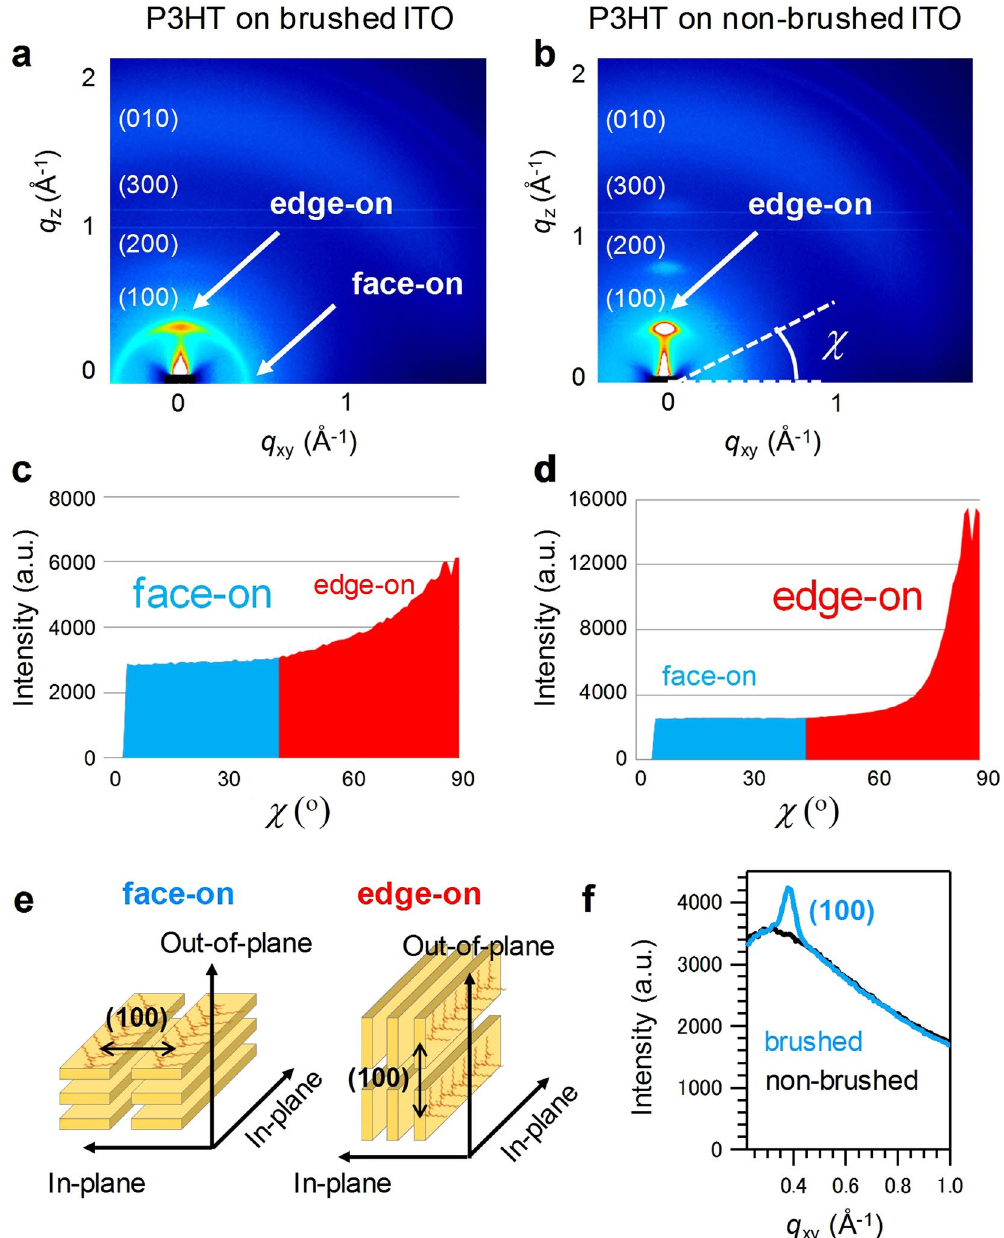
Figure 4. ( a , b ) GIXD patterns of P3HT thin films, and ( c , d ) intensities of (100) peaks as a function of the pole angle χ , for films on ( a , c ) brushed and ( b , d ) non-brushed substrates. The degrees of face-on and edge-on orientations correspond to the integrated intensities of χ = 0 to 45° and χ = 45 to 90°, respectively. ( e ) Schematic illustration of face-on and edge-on orientations. ( f ) GIXD intensity profile of the (100) diffraction along q xy obtained by integration from χ = 0 to